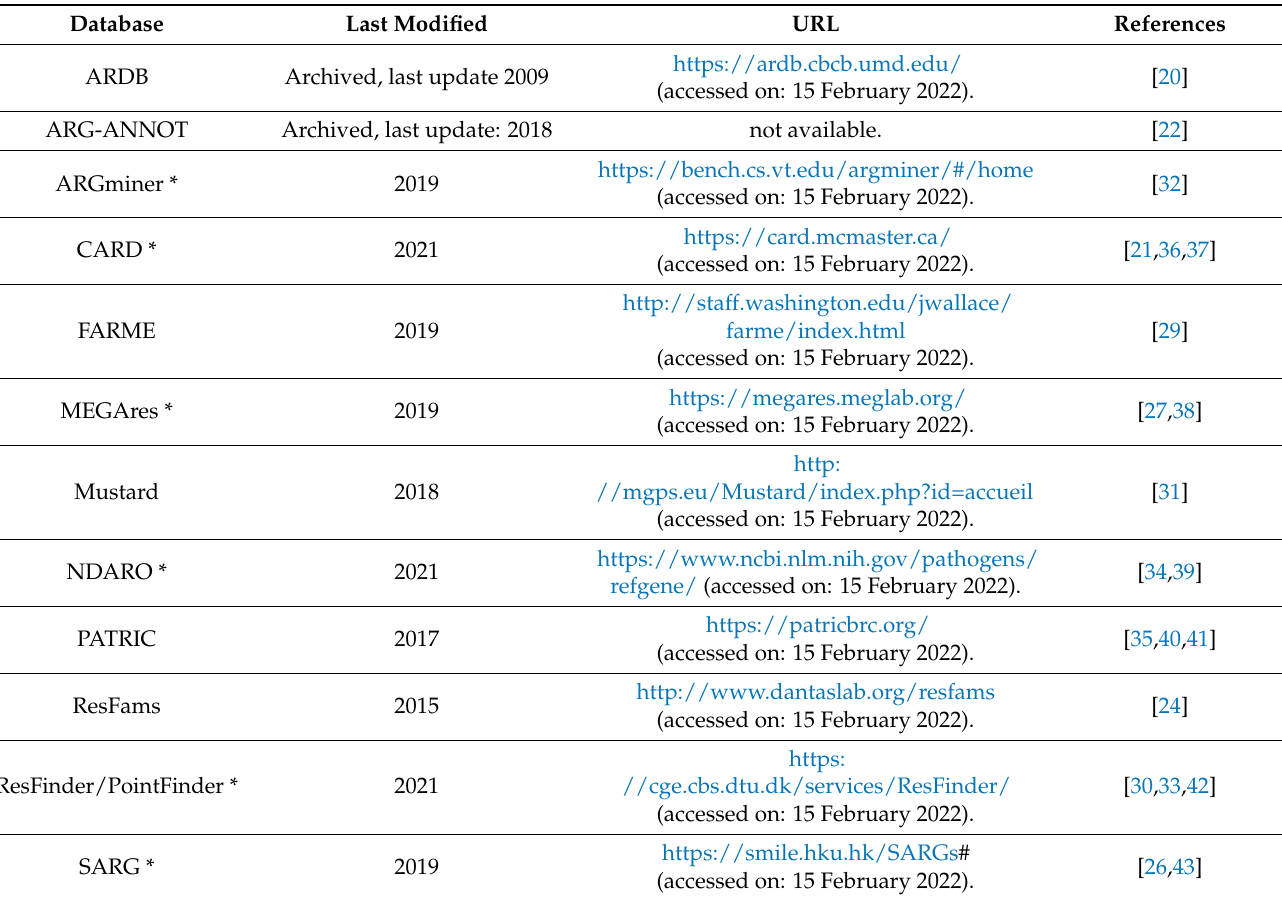
Table 1. Well-known ARG databases. The table contains the most well-known general ARG databases with additional information (the year of the last update of the database (Last Modi- fied), link address, where the database can be accessed (URL) and the publications associated with the database